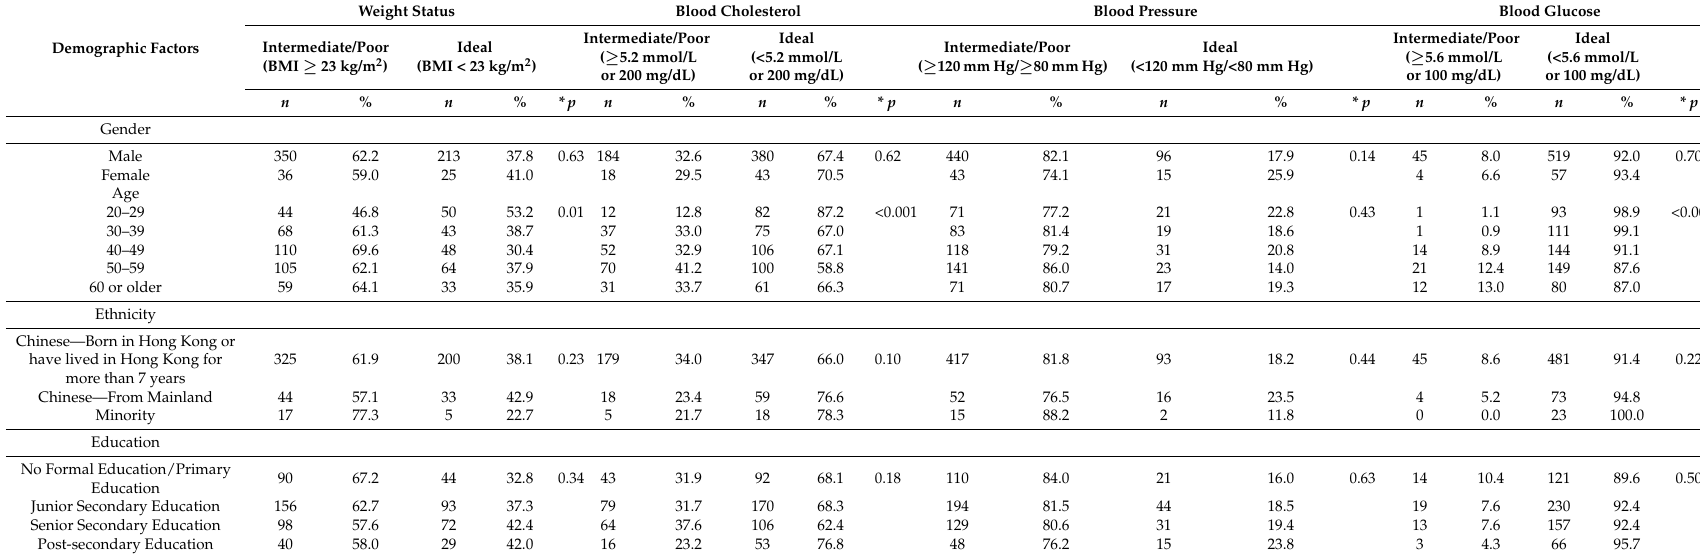
Table 2. Cardiovascular health